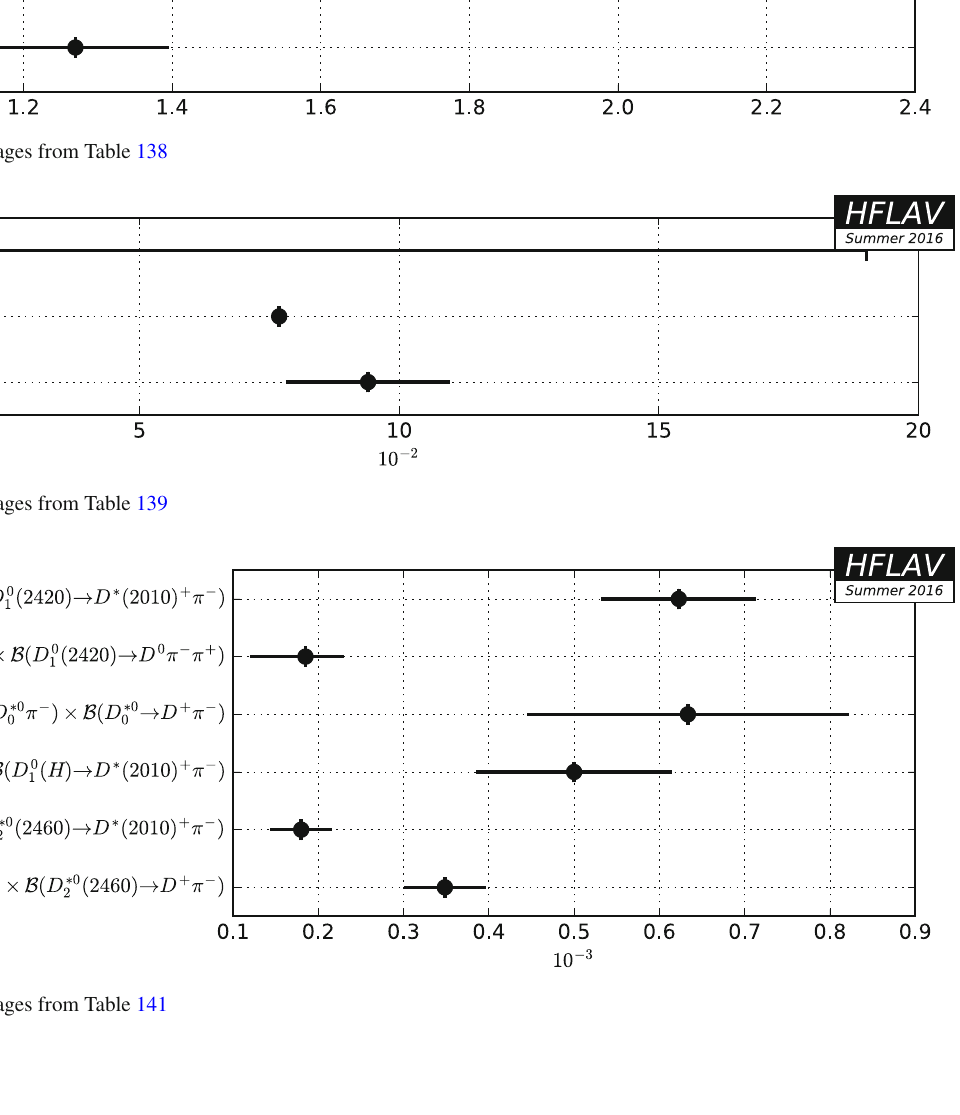
Fig. 111 Summary of the averages from Table